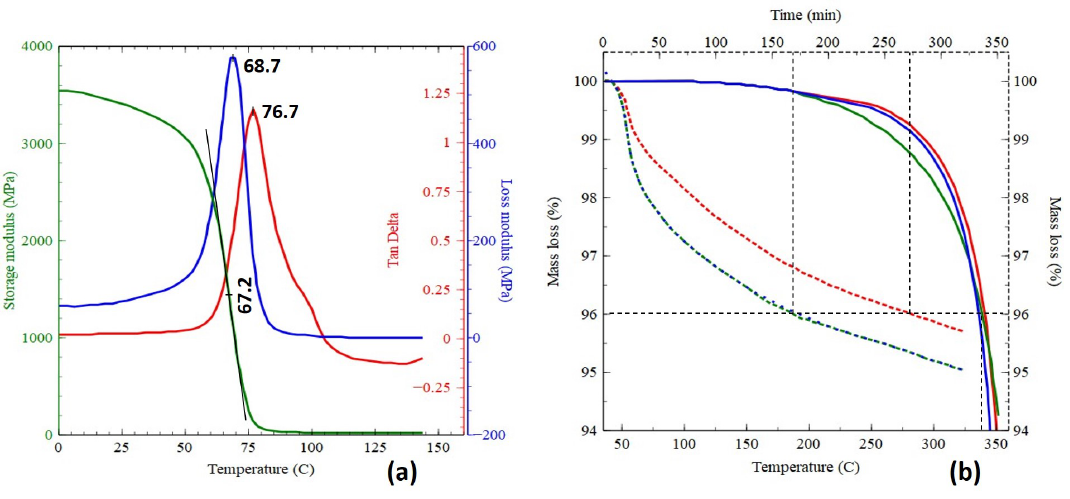
Figure 4. Thermoset (TS) matrix characteristics: ( a ) Dynamic mechanical analysis (DMA) results; ( b ) Thermal gravimetric analysis (TGA)